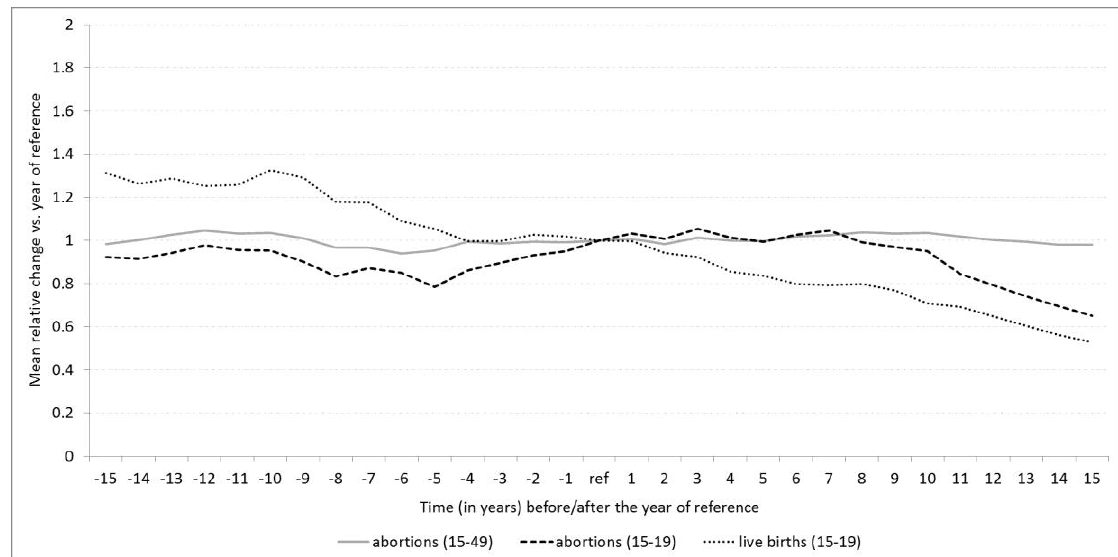
Figure 2. Long-term analysis of abortion/live birth rates 15 years before and after the year of reference for eight countries with a complete ±15 year-history before/after the EMC